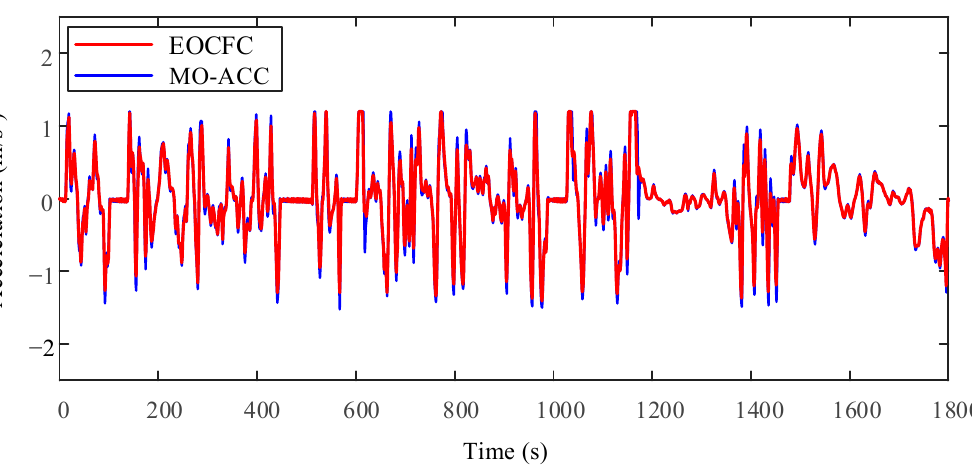
Figure 9. Inter-vehicle spacing resulting from the MO-ACC strategy ( a ) and the EOCFC strategy ( b ) under the WLTC test cycle.